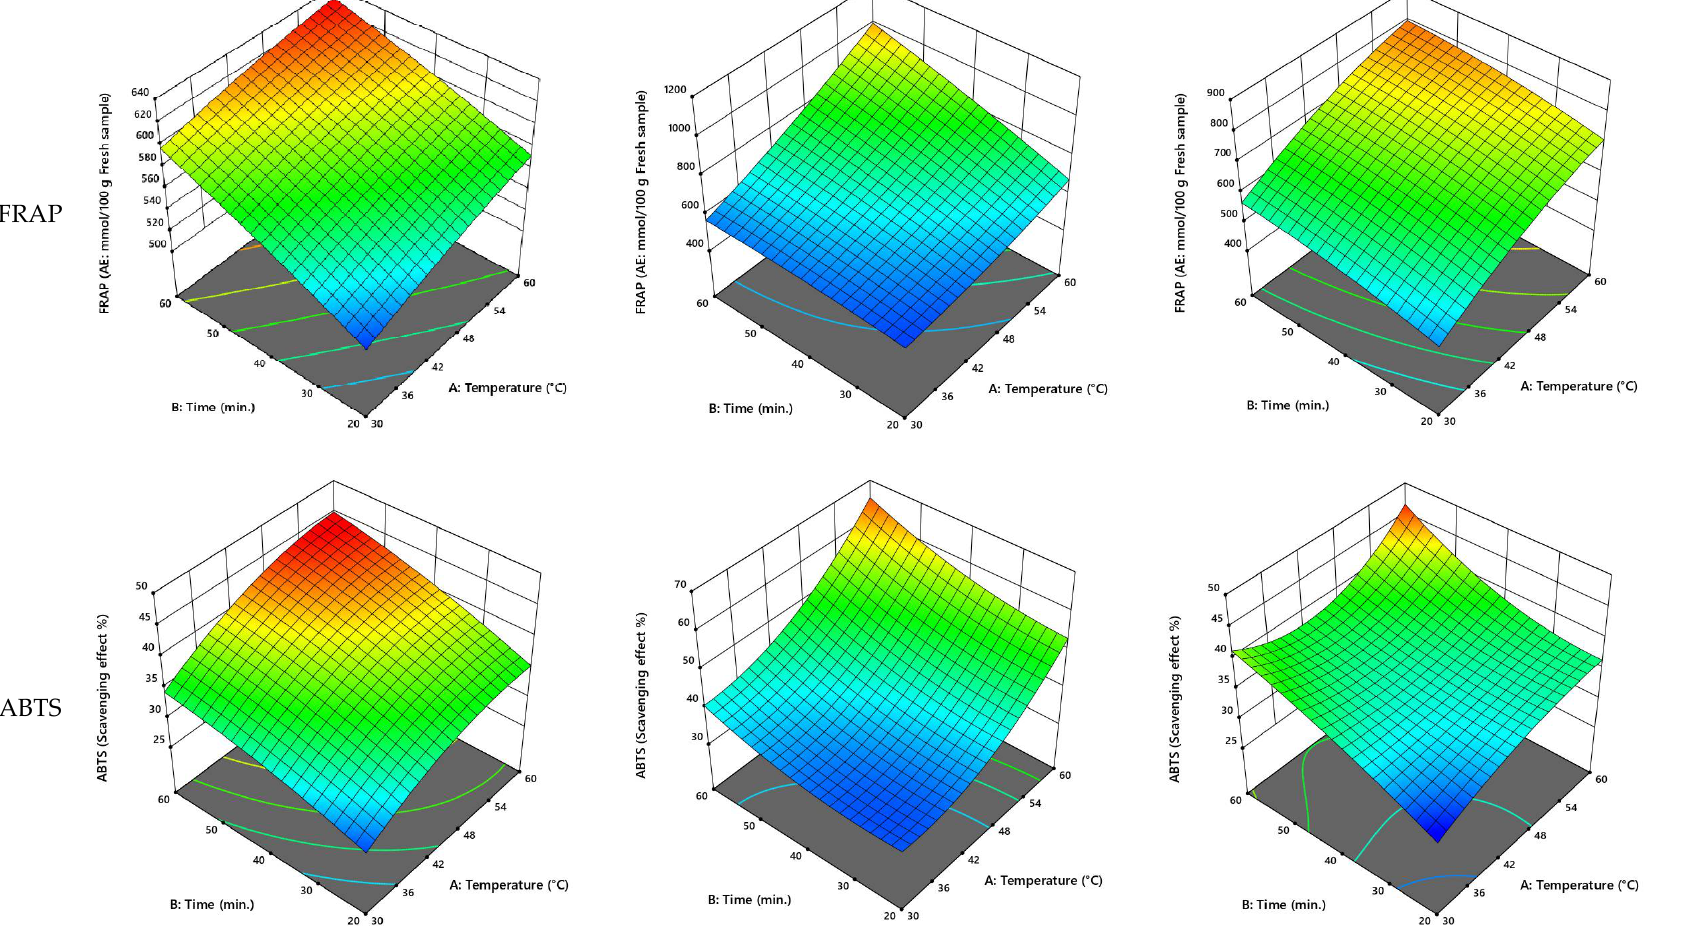
Figure 4. 3D response surface plot for response variables (TPC, TFC, FRAP, and ABTS) as a function of UAE with frequency 0, 28, and 40 kHz in Reziz date palm fruit cultivar.